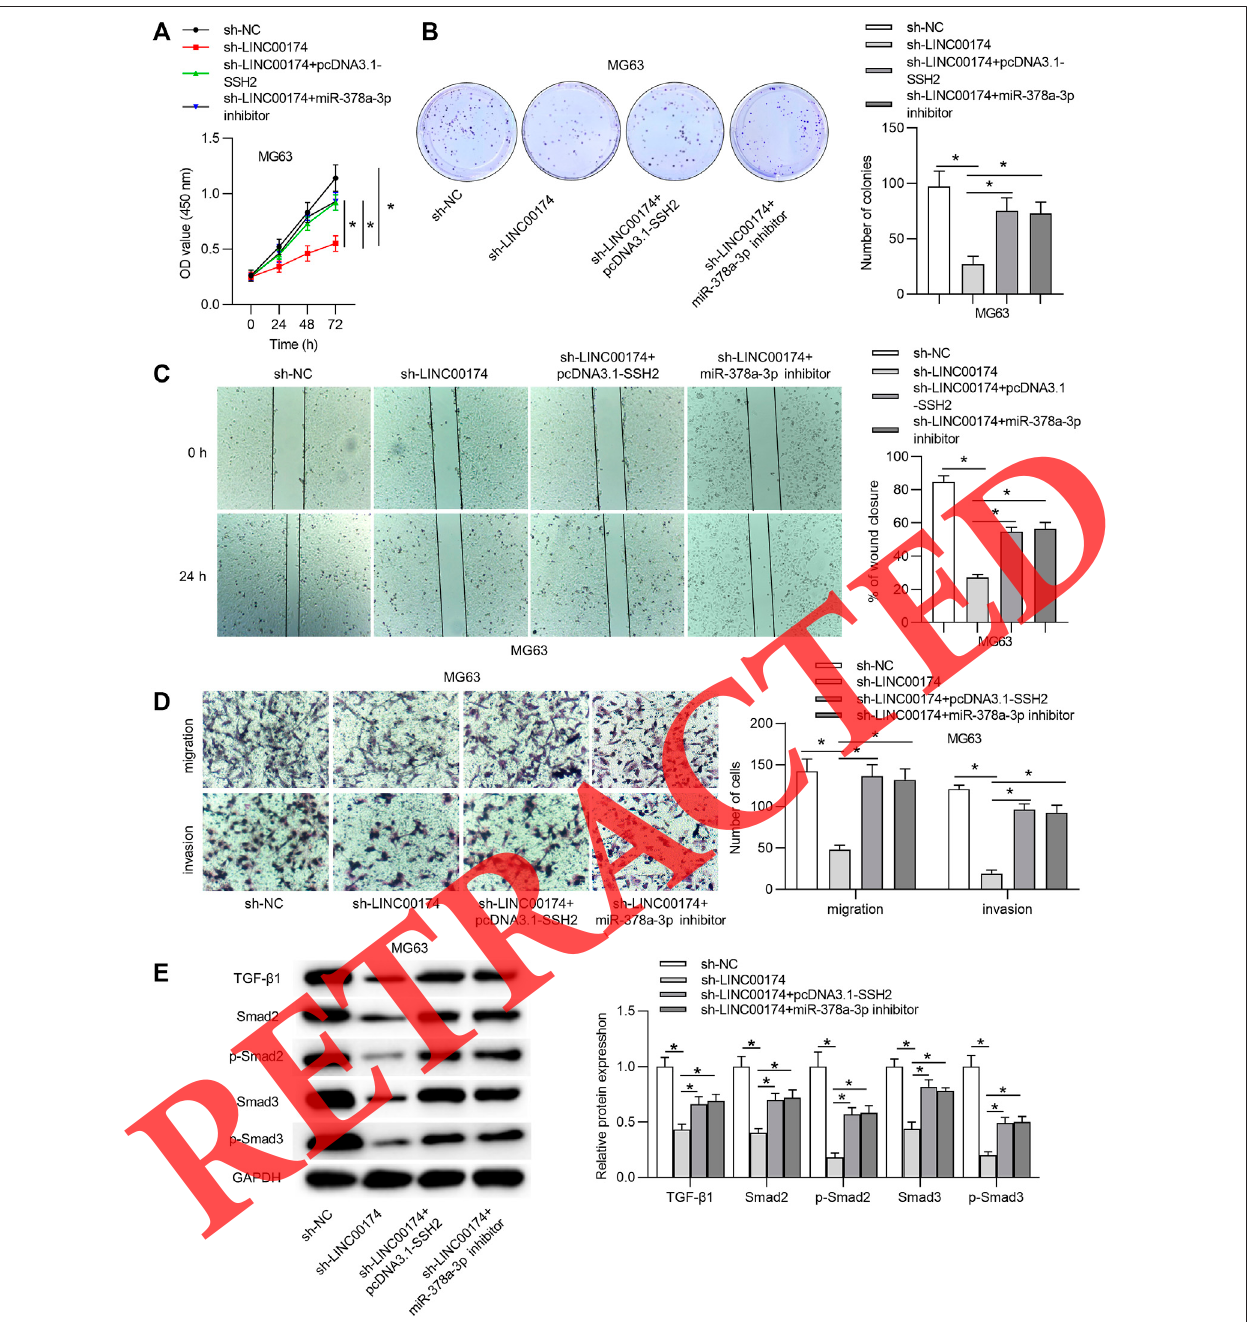
FIGURE7| LINC00174promotescellproliferation,migrationandinvasionandactivatestheTGF- β /SMADpathwayinOSprogressionbyregulatingthemiR-378a- 3p/SSH2 axis. (A,B) Cell viability and proliferation in MG63 cells in each group was detected using CCK-8 and colony formation assays. Signi fi cance was analyzed by ANOVA followed by Tukey ’ s post hoc test. (C,D) The migration and invasion of OS cells by different transfection conditions were measured by wound healing and Transwell assays. Signi fi cance was analyzed by ANOVA followed by Tukey ’ s post hoc test. (E) The protein levels of TGF- β 1, SMAD2, SMAD2 (phospho S255), SMAD3, and SMAD3 (phospho T179) in MG63 cells in each group were evaluated by western blot analysis. Signi fi cance was analyzed by ANOVA followed by Tukey ’ s post hoc test. * p < 0.05.